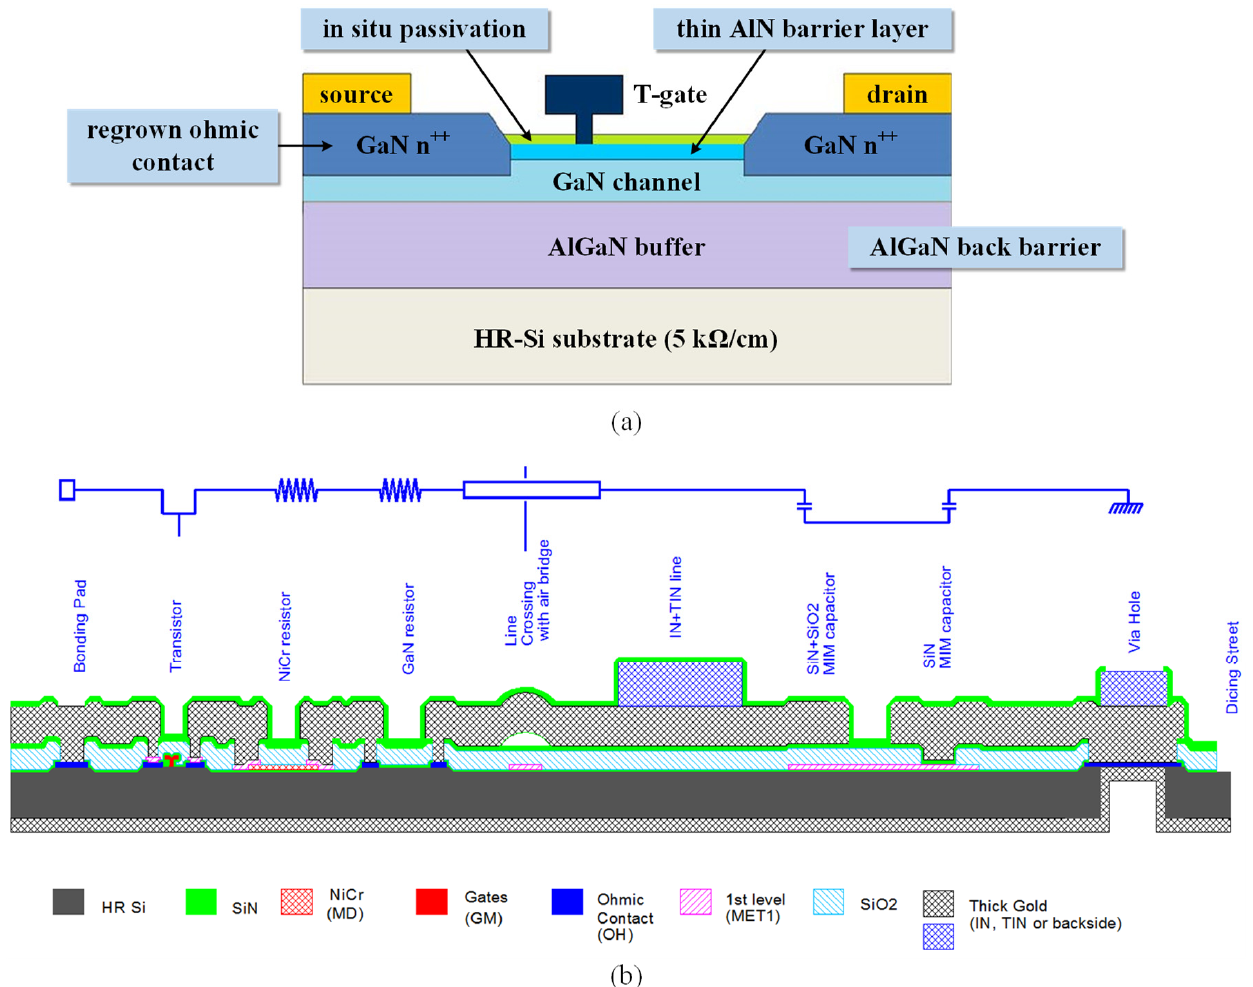
Figure 1. ( a ) Epitaxial structure and ( b ) cross-section of OMMIC’s 0.1 μ m GaN-on-Si process.